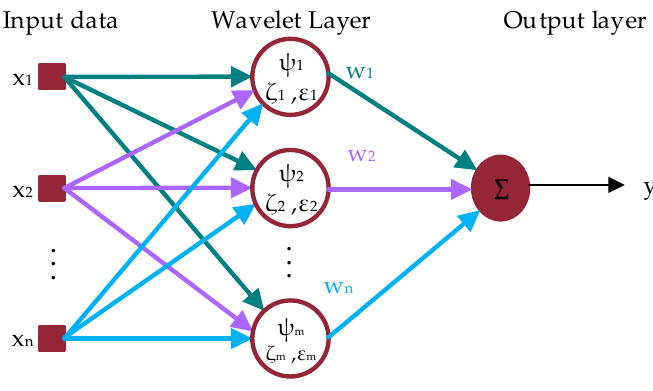
Figure 7. Wavelet neural network structure.